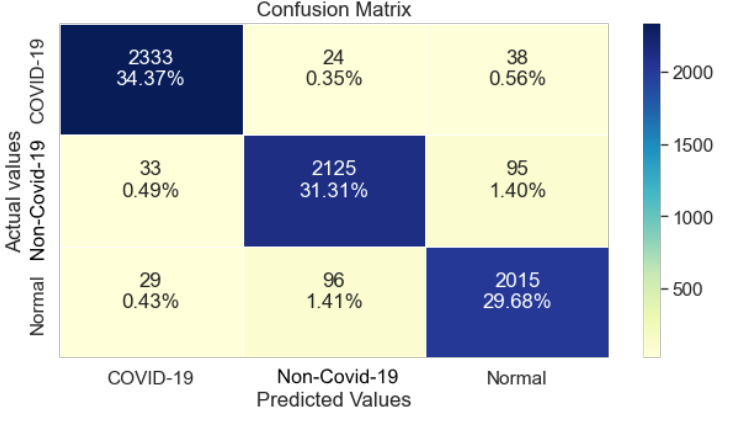
Figure 3. ResNet50 Confusion Matrix.